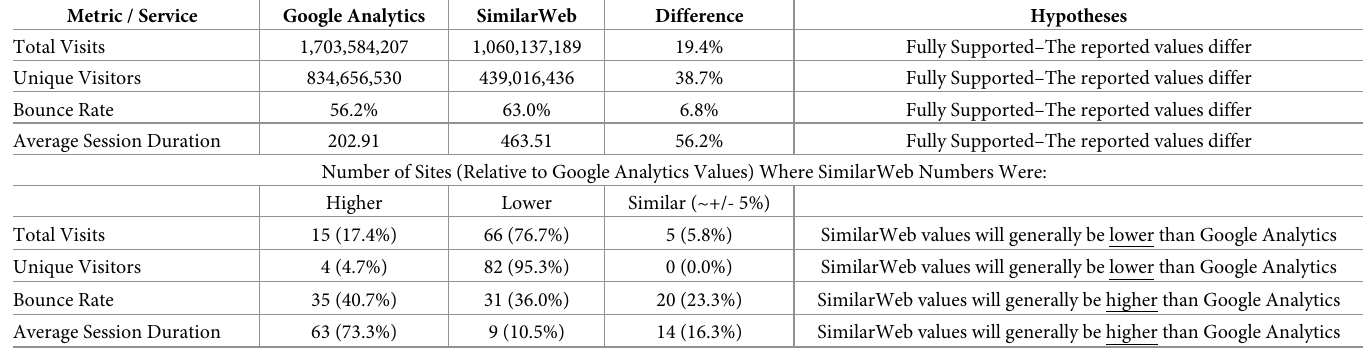
Table 6. Summary of results comparing Google Analytics and SimilarWeb for total visits, unique visitors, bounce rate, and average session duration. Difference uses Google Analytics as the Baseline. Results based on Paired t-Test for Hypotheses Supported. Metric /